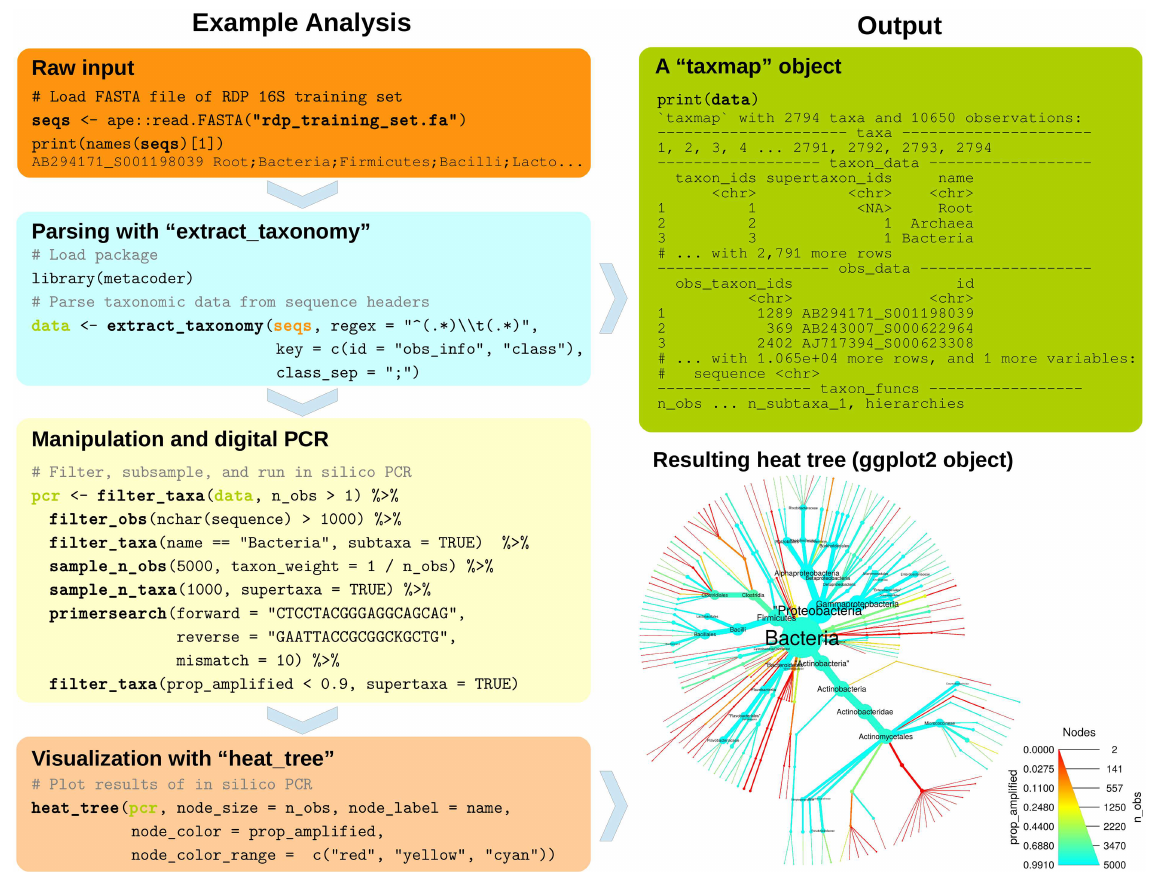
Fig 1. Metacoder has an intuitive and easy to use syntax. The code in this exampleanalysisparses the taxonomicdata associated with sequencesfrom the Ribosomal DatabaseProject [9] 16S trainingset, filters and subsamplesthe data by sequence and taxon characteristics, conducts digital PCR, and displaysthe results as a heat tree. All functions in bold are from the metacoder package.Note how columns and functions in the taxmap object (green box) can be referenced within functionsas if they were independent